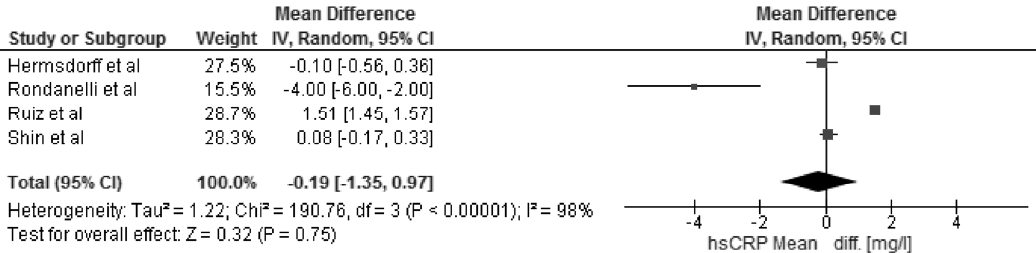
Figure 7. Forest plot of the random-effects meta-analysis of changes in high sensitivity C-Reactive Protein according to reduction in energy intake shown as polled standard differences in the means with 95% Cis and in randomized and non-randomized trials. * For each study, the square represents the point estimate of the intervention effect. Horizontal lines join the lower and upper limits of the 95% CI of this effect. The area of shaded squares reflects the relative weight of the study in the meta-analysis. Diamonds represent the subgroup mean difference and pooled mean differences. CI indicates confidence interval.